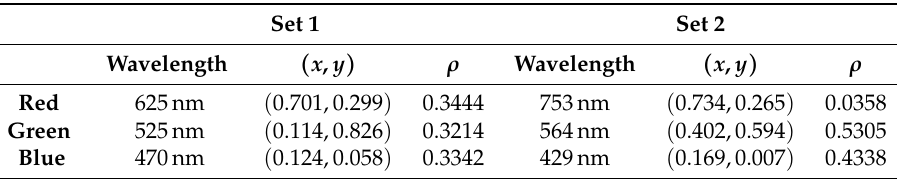
Table 3. RGB primaries